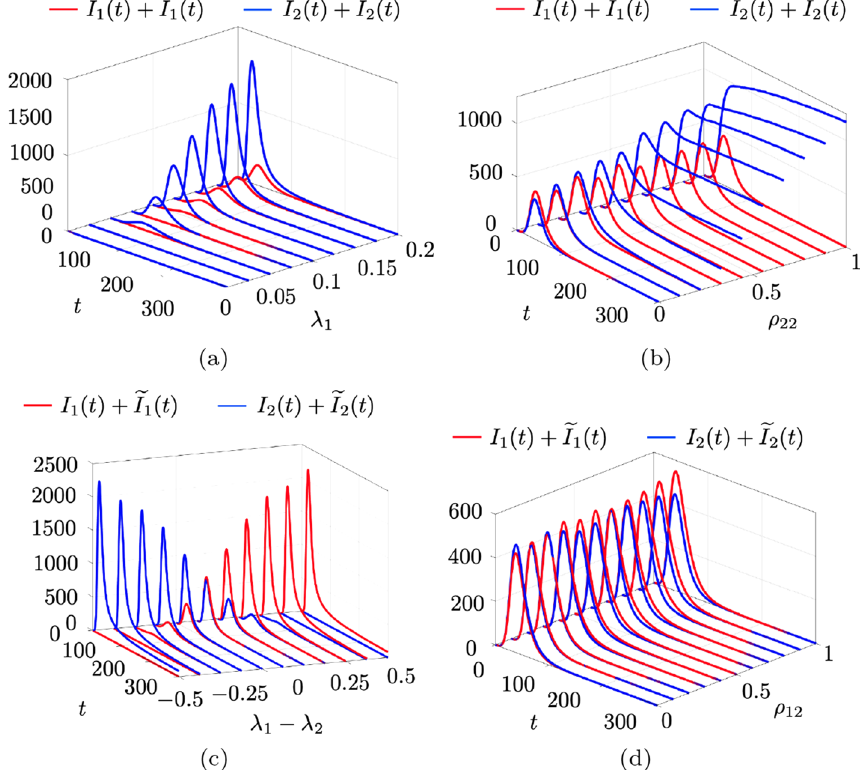
Fig. 2 Illustrative example of the time evolution of the epidemic spreading process. Evolution of the epidemic in terms of the total infection counts for strain 1 ( I 1 ( t ) +˜ I 1 ( t ) ) and 2 ( I 2 ( t ) +˜ I 2 ( t ) ), averaged over 1000 independent Monte Carlo simulations for a different values of (cid:31) 1 with (cid:31) 2 = 2 (cid:31) 1 being twice infectious than the first variant. Here (cid:31) 1 is varied from 0 to 0.2, thus representing cases where both variants are in the non‑epidemic regime and transition to an epidemics as (cid:31) 1 increases. b Re‑infection parameter of the second variant ρ 22 with ρ 21 = ρ 22 and (cid:31) 1 = (cid:31) 2 = 0.2 . c (cid:31) 1 varies between 0 and 0.5, while (cid:31) 2 = 0.5 − (cid:31) 1 . d Number of re‑infected individuals varying the cross‑strain re‑infection probability ρ 12 with (cid:31) 1 = (cid:31) 2 =